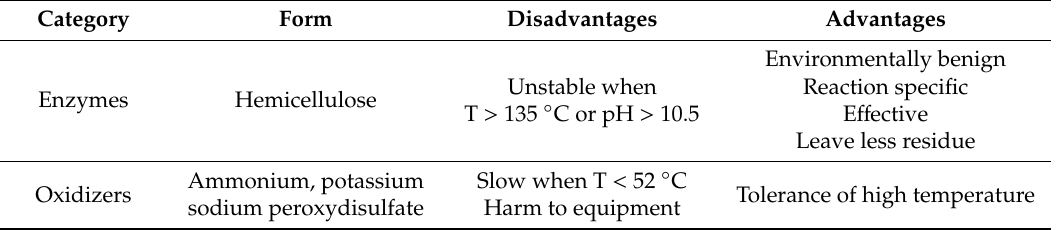
Table 6. The breakers of hydraulic